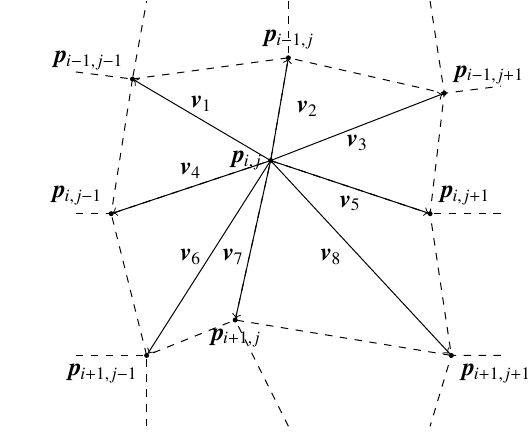
Figure 4. Neighborhood of p i,j with vectors v 1 ,..., v 8 pointing to all direct neighbors of p i,j